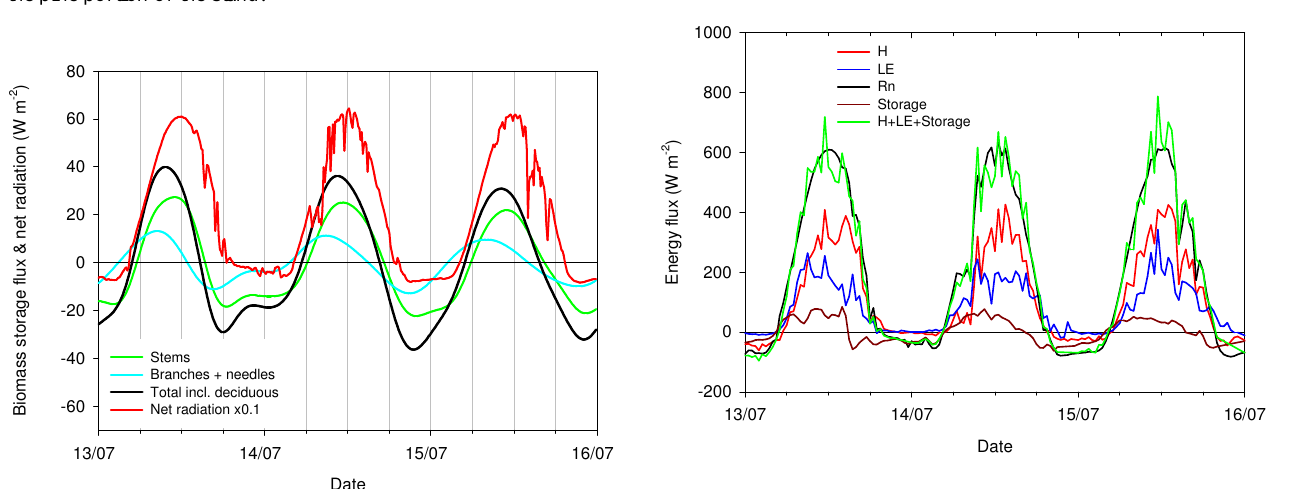
Fig. 6. Diurnal courses of all energy fluxes during three summer